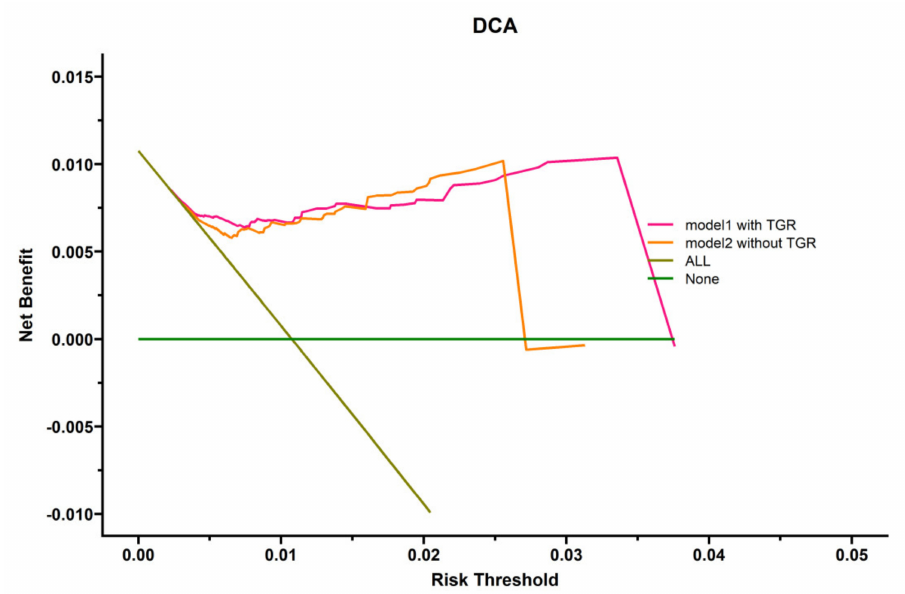
Figure 4. Decision curve analysis (DCA) of several prognostic models in HHCC patients.